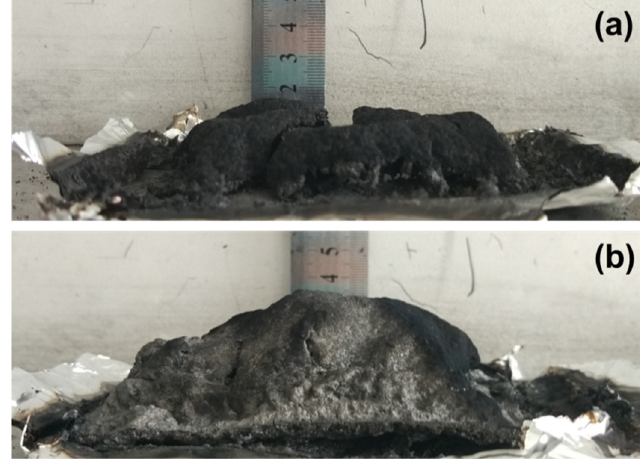
Figure 4. Digital photographs of PLA and PLA composites after CONE test from a horizontal per- spective: A1C1M0 ( a ) and A2C1M1 ( b